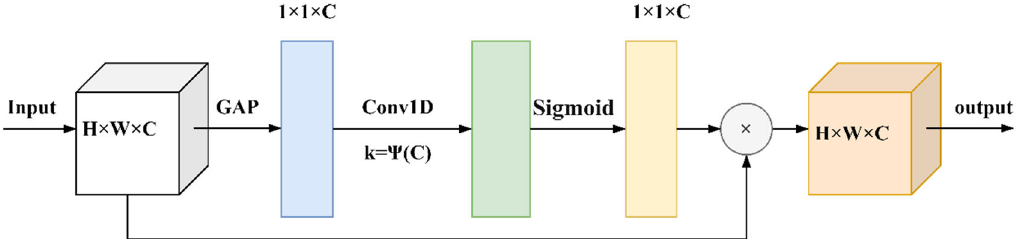
Figure 2. This is a diagram of our efficient channel attention (ECA) module. Using aggregated features generated by global average pooling (GAP), ECA generates channel weights by performing a fast 1D convolution of size k, where k is adaptively determined based on channel dimension C.